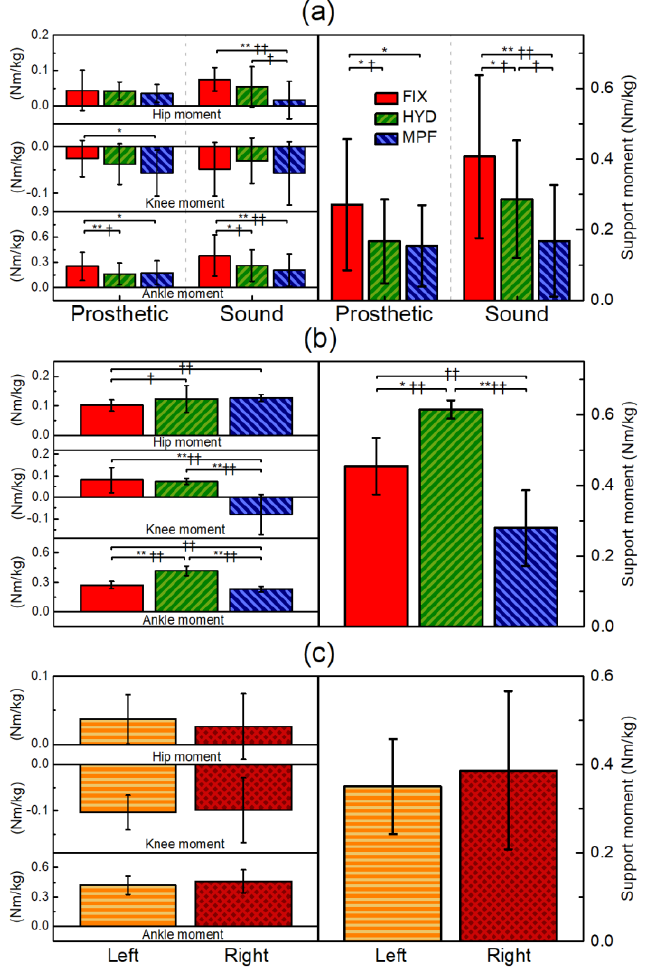
Figure 2: The relative contributions of ankle, knee and hip moment to the total support moment for (a) unilateral trans-tibial amputees, (b) a bilateral trans-tibial amputee and (c) able-bodied control participants. Asterisks indicate statistical significance: *p<0.05, **p<0.01. Obelisks indicate effect size changes: †|d|>0.5,